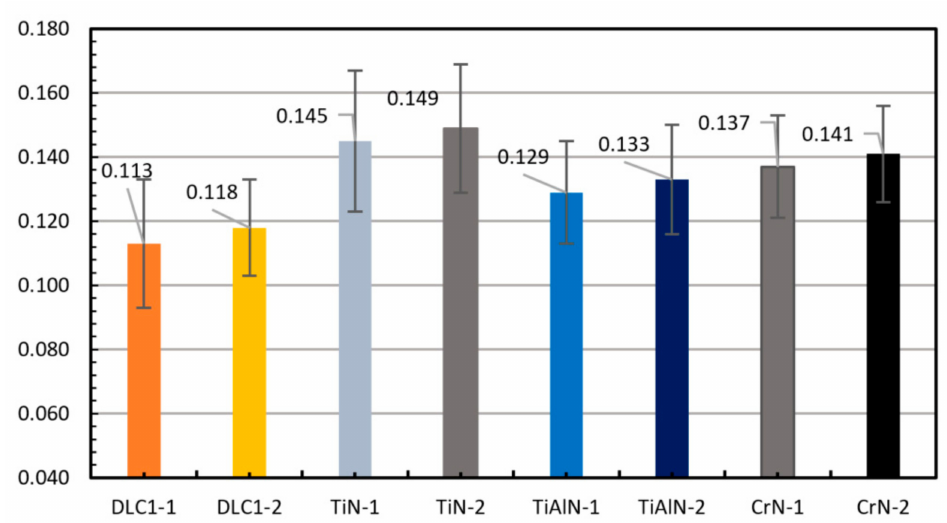
Figure 4. Average values of the coefficients of friction measured for test specimens with the same coatings as on the piston